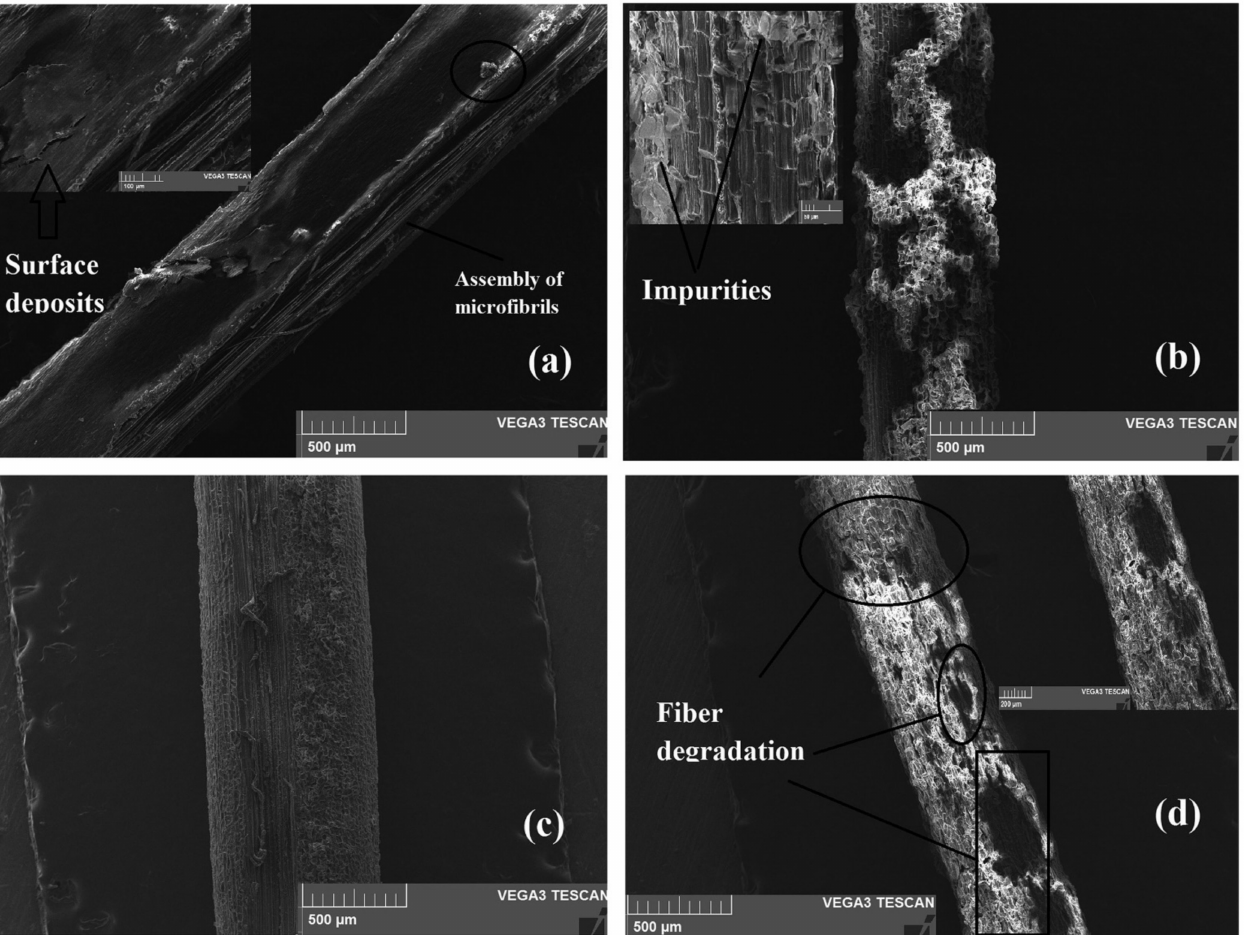
Figure 7. SEM micrographs showing the effect of NaOH treatment on date palm fiber texture compared to raw fiber: ( a ) raw fiber, ( b ) 2% alkali treated, ( c ) 5% alkali treated and ( d ) 10% alkali treated [75]. (Open